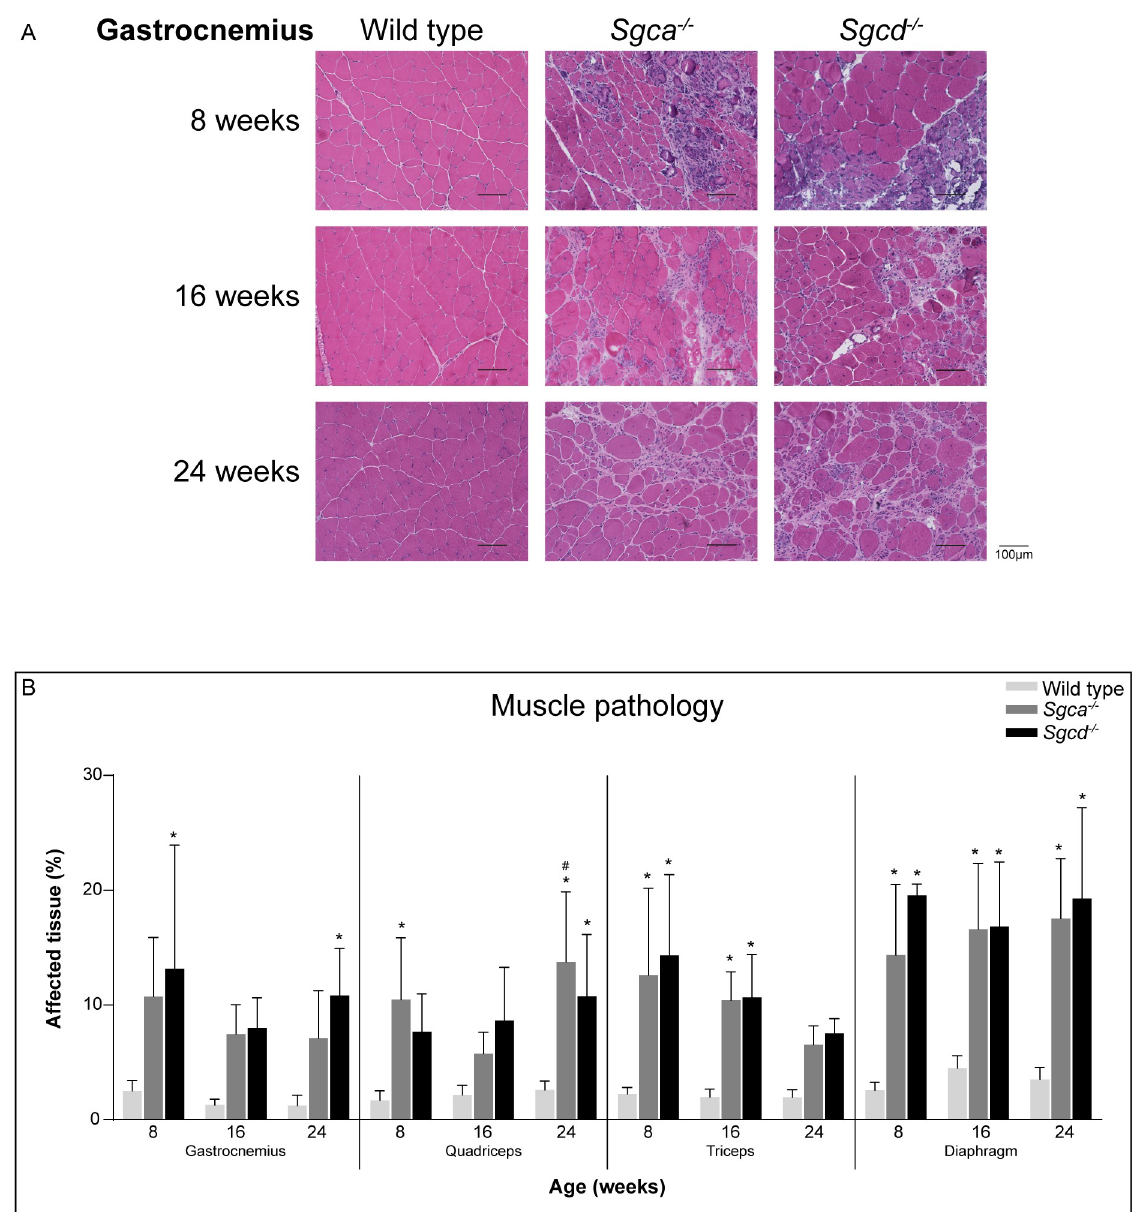
Fig 2. Histological analysis of muscle quality. (A) Representative images (20x magnification) of H&E staining of the gastrocnemius of each genotype and age group. Scale bars represent 100 μ m. (B) Quantification of affected tissue. N = 6 male mice per group. � p < 0.05 vs age- matched wild type mice, # p < 0.05 over time (same